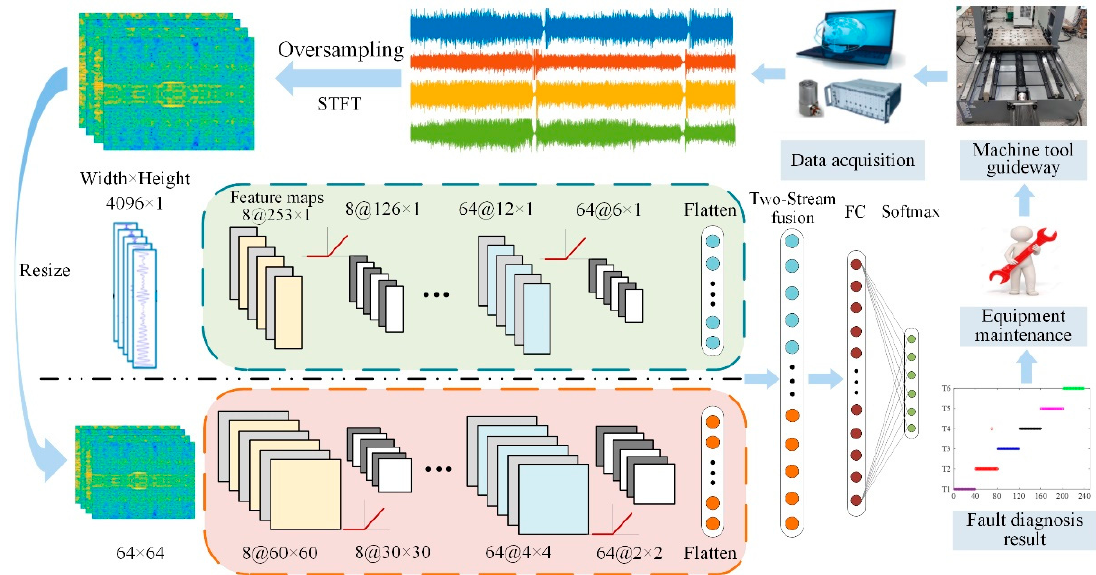
Figure 3. The structure illustration of the TSCNN model.